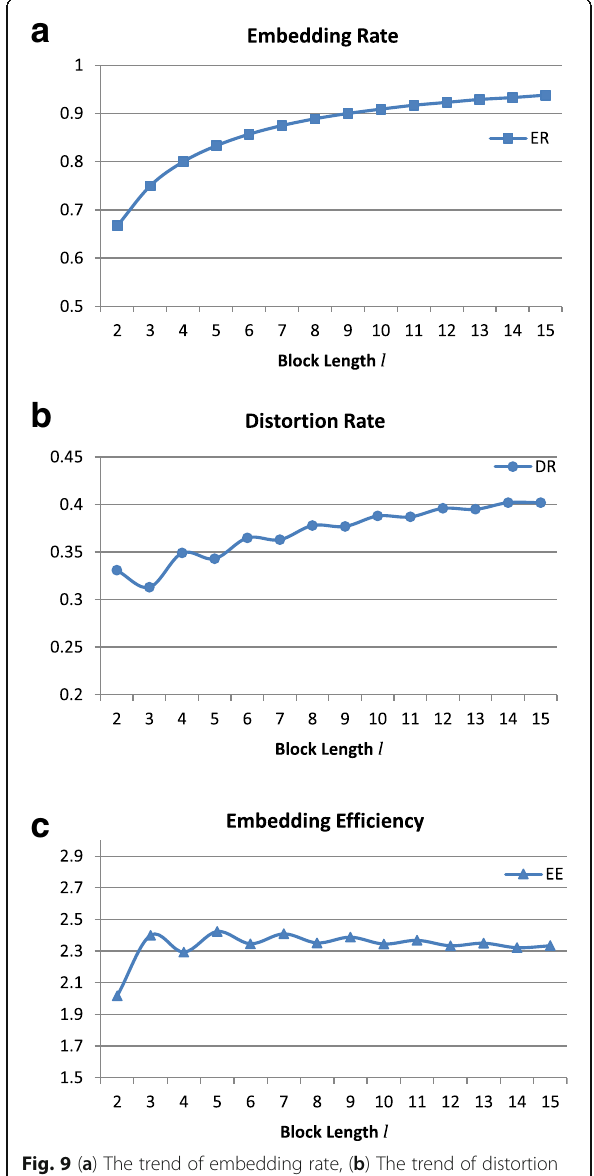
Fig. 9 ( a ) The trend of embedding rate, ( b ) The trend of distortion rate and ( c ) The trend of embedding